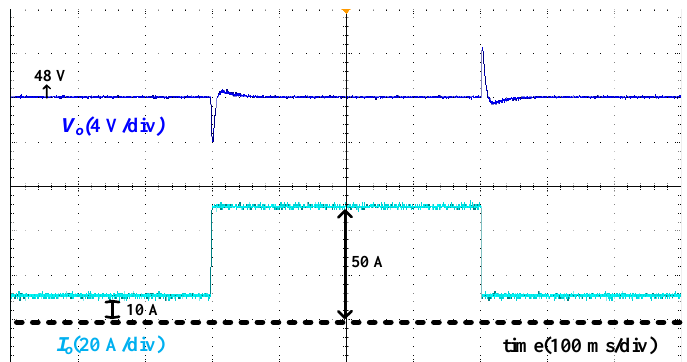
Figure 26. Dynamic load waveform from 10 A to 50 A.